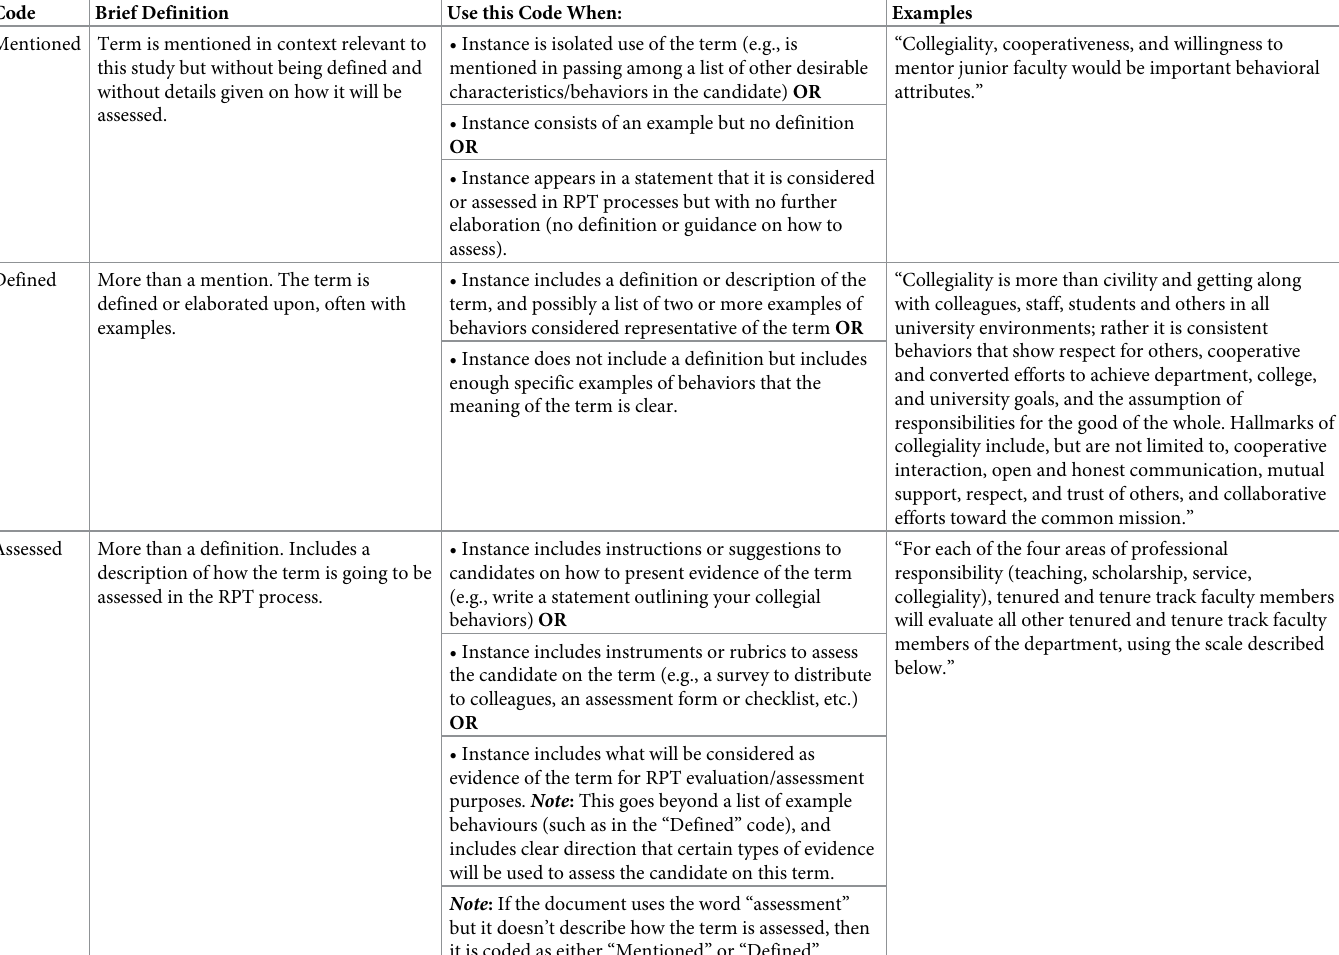
Table 2. Codes, definitions, and examples for the qualitative analysis of the RPT